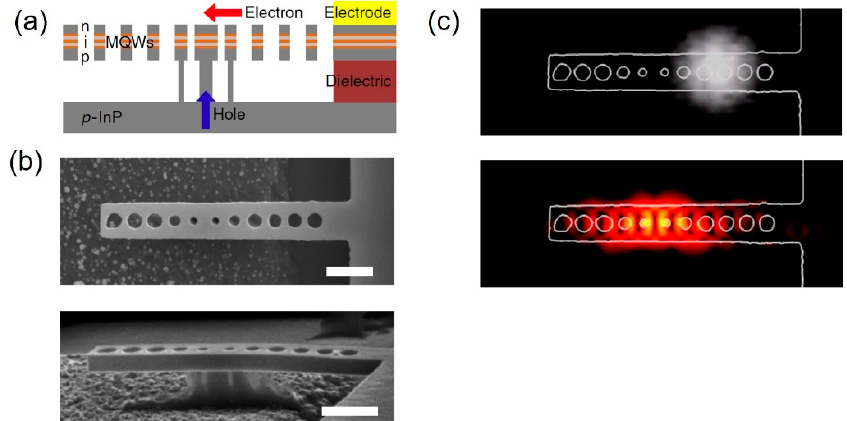
Figure 4. Electrically driven 1D PhC nanocavity lasers. ( a ) Schematic illustration of an electrically driven 1D nanobeam cavity. Carriers are injected from the top electrode and bottom post to the central nanocavity region. ( b ) Fabricated nanobeam nanolaser with an extremely small device footprint (top and bottom). Sub-micron post structures support the cavity structure. ( c ) Measured electroluminescence (EL) image (top) and finite-difference time-domain (FDTD)-calculated electric filed intensity distribution (bottom) [29]. Figure reproduced with permission from Springer Nature Limited.